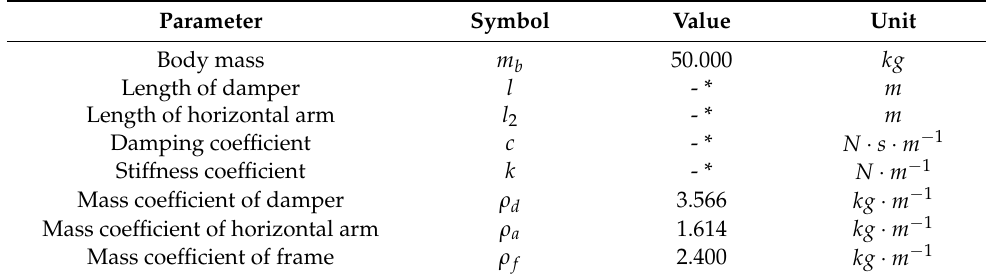
Table 1. Parameter setting of the quarter suspension